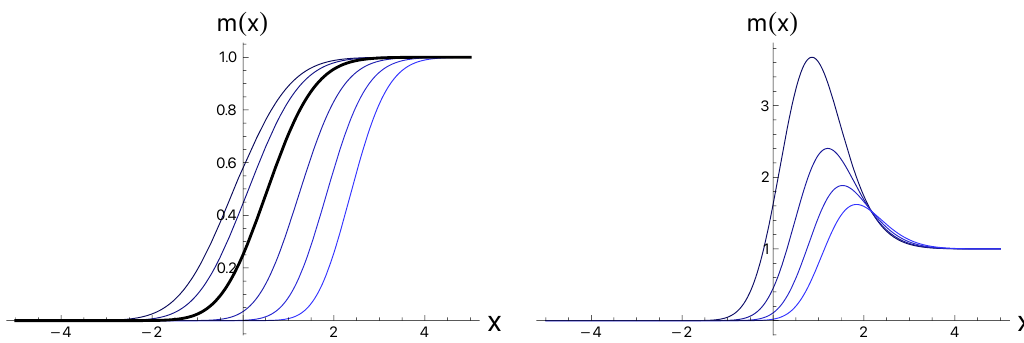
Figure 6 . Solution profiles for droplets. The left panel shows the first droplet branch for α = 0 . 2 , 0 . 5 , 1 , 2 , 3 , 4 to the right. The thick black curve corresponds to the analytic solution with the error function for α = 1 . The right panel shows the second droplet branch for α = 2 . 5 , 3 , 3 . 5 , 4 to the